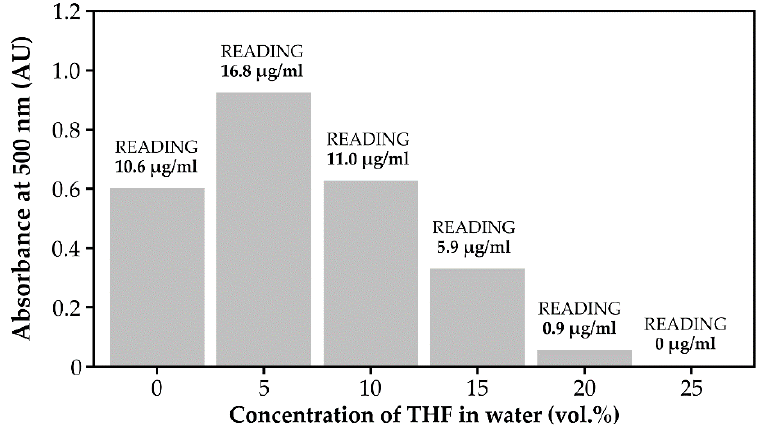
Figure 1. Influence of THF contamination on the reading of Nessler’s tests of aqueous ammonia solutions. Starting solution of 10 μ g/mL diluted with portions of pristine THF.